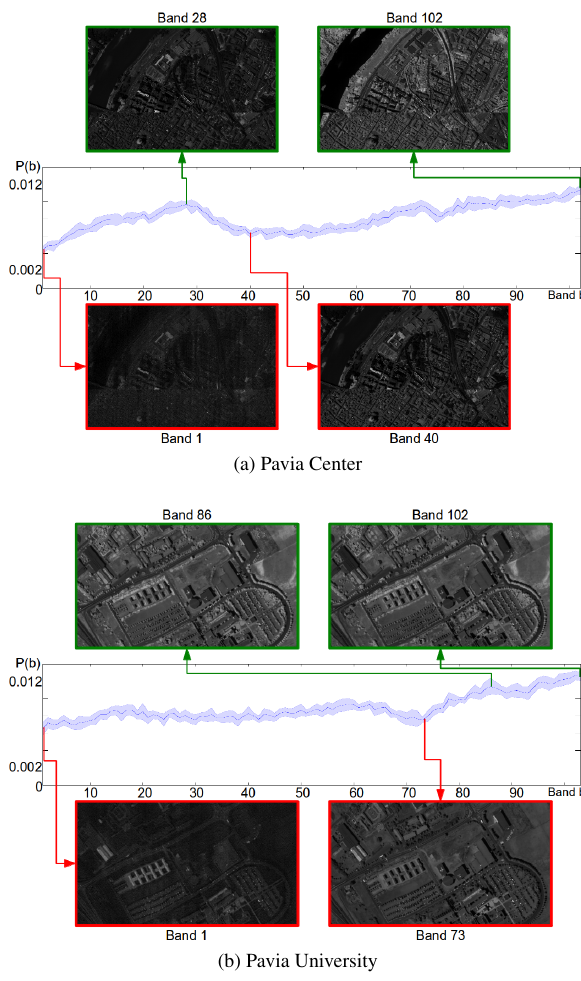
Figure 3: Usage frequency of spectral bands with exemplary in- formative and noninformative bands